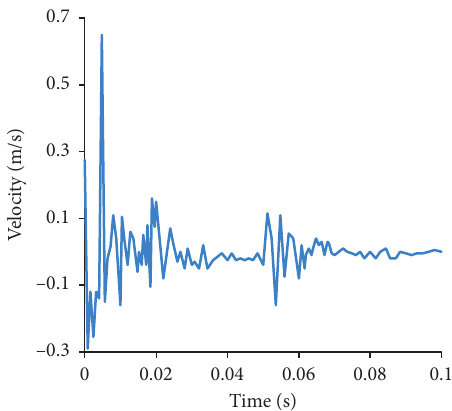
Figure 9: Blasting vibration velocity curve measured at the tunnel wall.